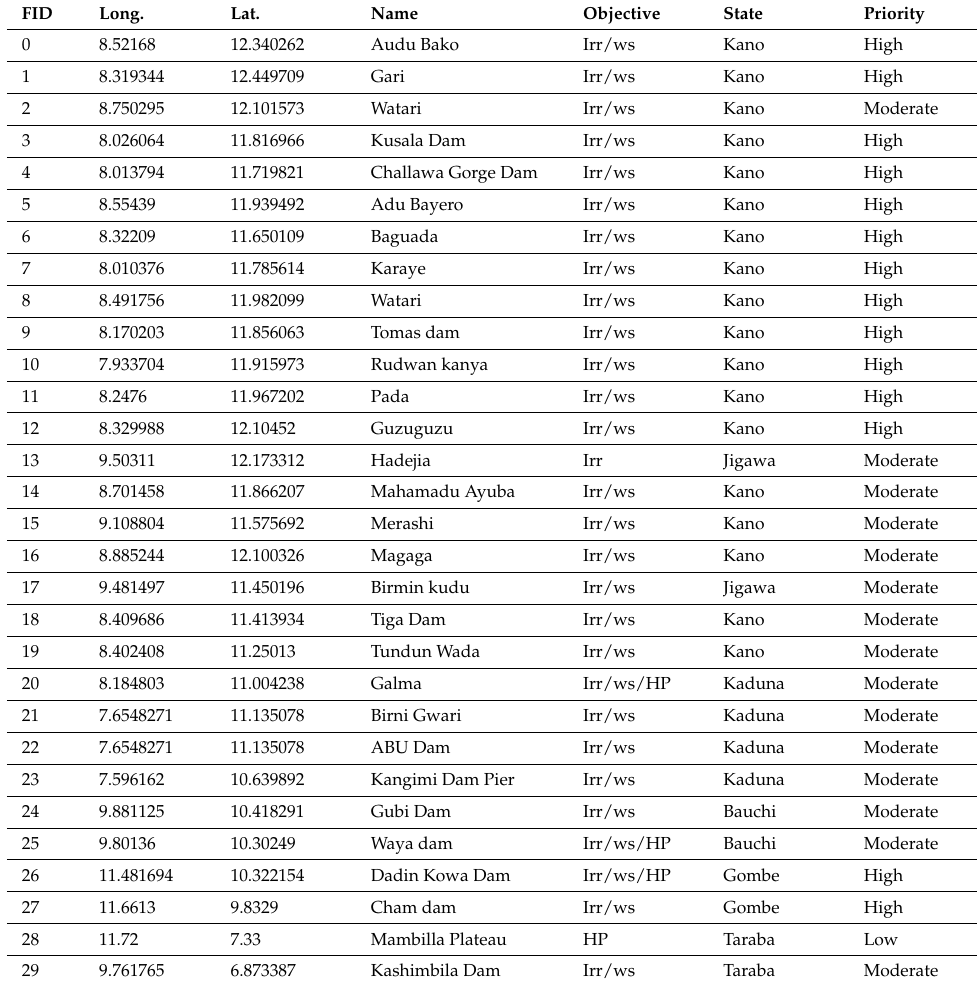
Table 4. Locations of dams and their purpose. FID Long.